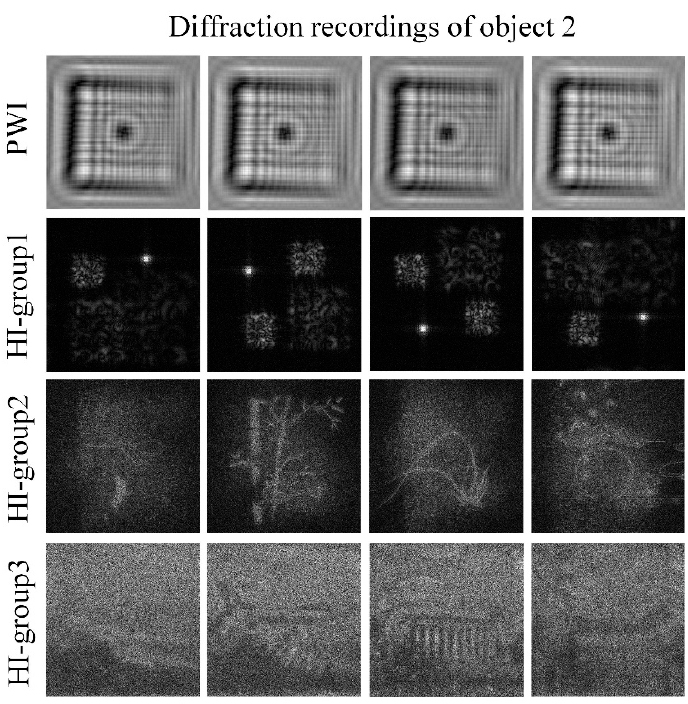
Figure 4. The recorded diffraction patterns of the vortex phase under different types of illumina- tion.